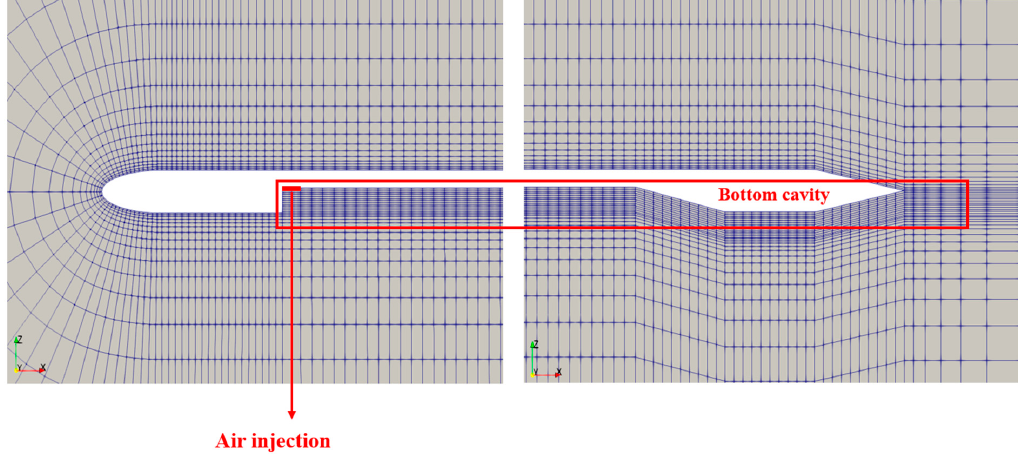
Figure 7. Typical meshes at the y = 0 plane.